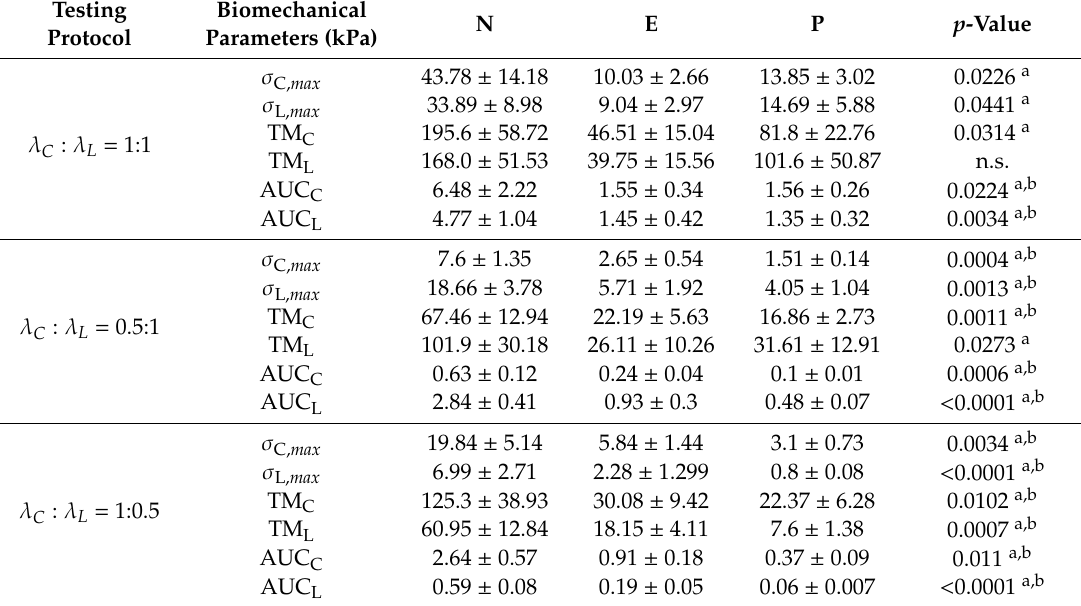
Table 1. Biomechanical parameters calculated from biaxial tensile testing of porcine abdominal aorta specimens for the three experimental groups (native (N), enzyme-treated (collagenase and elastase) (E), and pentagalloyl glucose (PGG) (P)). Values are reported as mean ±